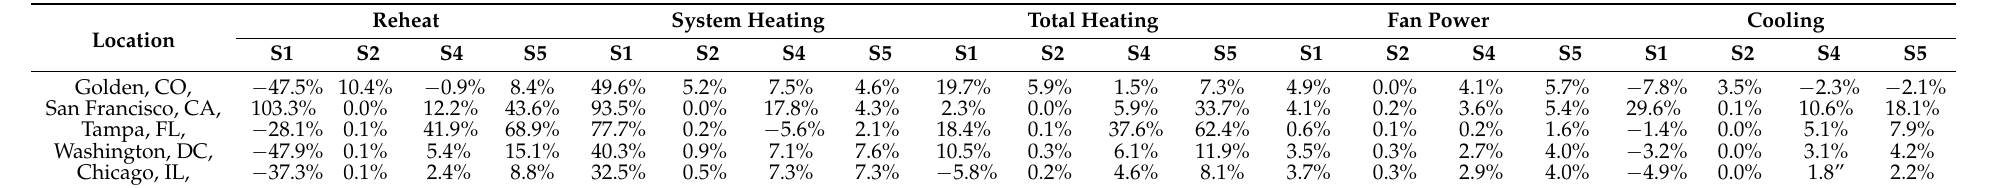
Table 3. Percentage changes of fan energy consumption and cooling and heating loads from the baseline, Strategy S3 (positive sign is energy or load saving or